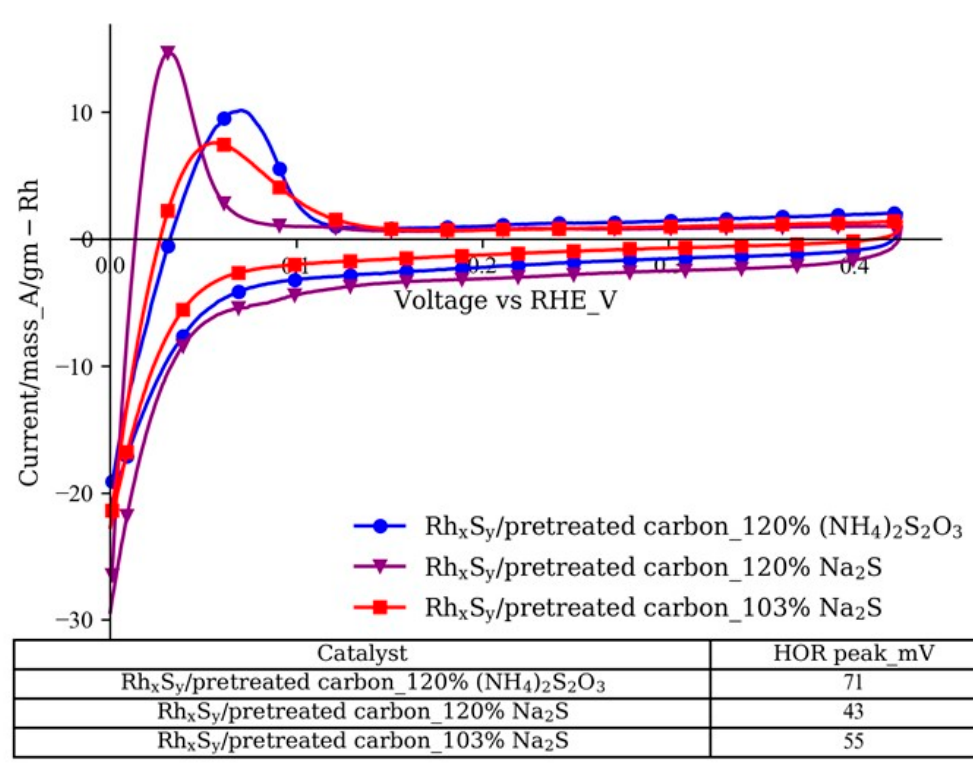
Figure 7. Cyclic voltammograms of Rh x S y catalysts with different excess levels of sulfur sources (electrolyte: 1 M N 2 -saturated H 2 SO 4 solution; working electrode: catalyst-coated GDE; counter electrode: Pt foil; reference electrode: SCE; scan rate: 10 mV/s).